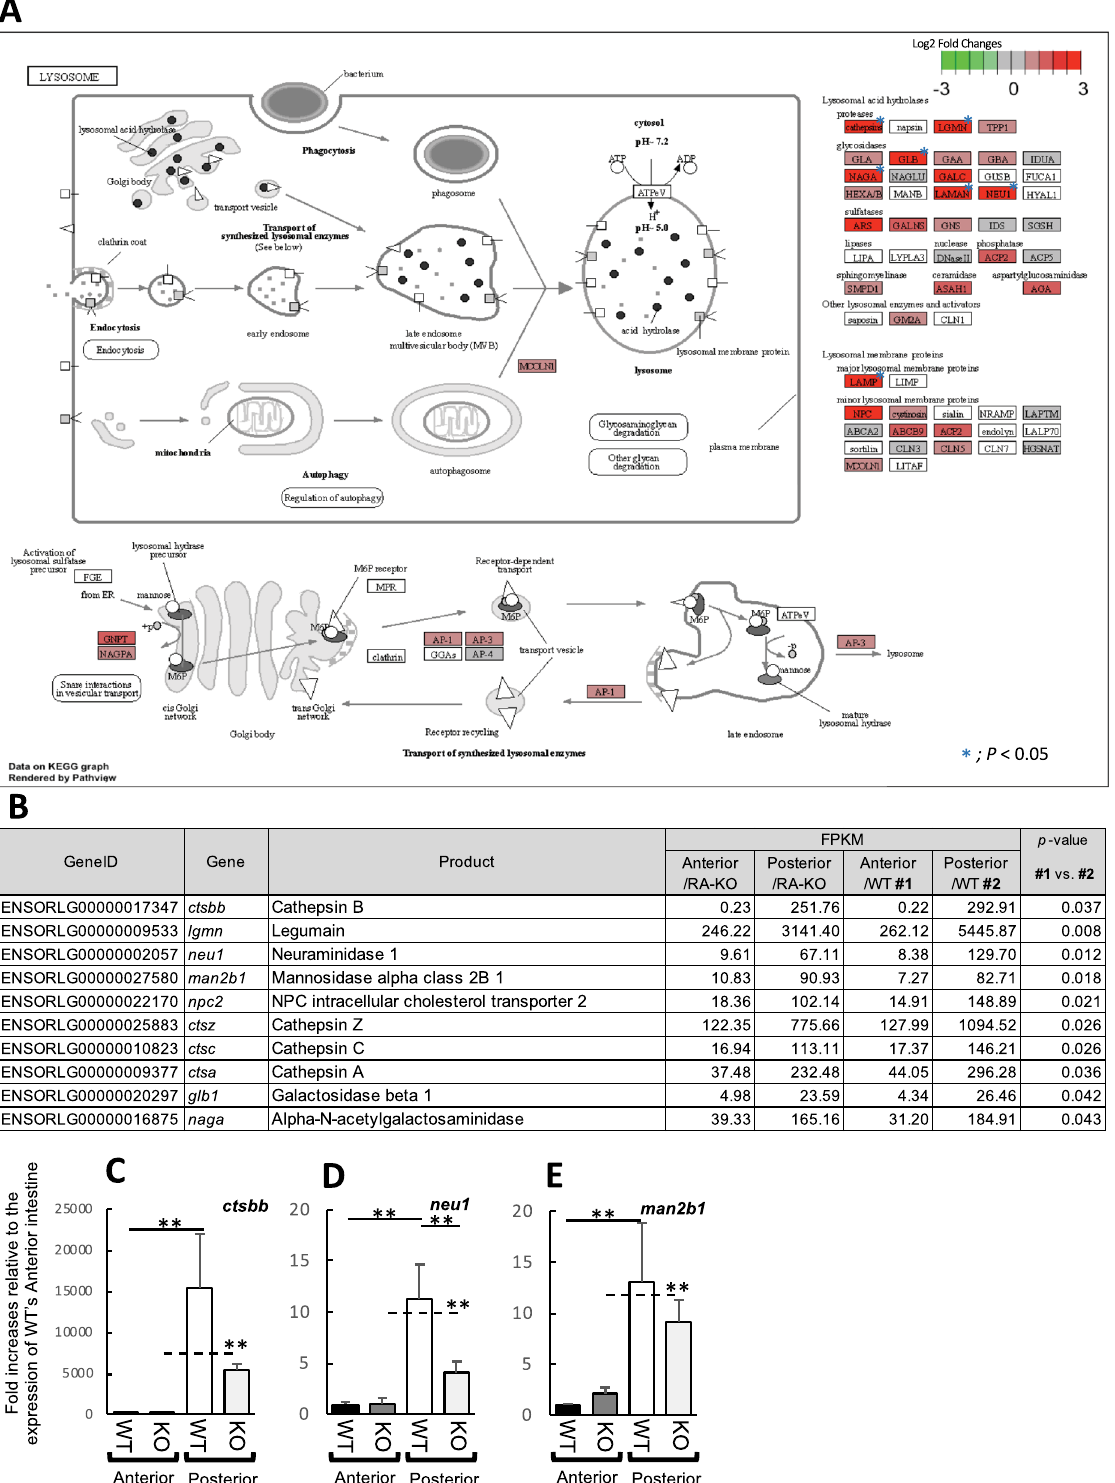
Figure 6. Pathway maps of notable DEGs in the posterior intestines, as determined using the KEGG database. ( A ) Medaka posterior intestines showed enhanced expression of genes related to the “lysosome” (KEGG map04142) pathway, as participated in lysosome formation. ( B ) Ten DEGs were significantly localized in the anterior intestines of WT medaka. ( C–E ) Of these 10 DEGs, the expression levels of cathepsin B ( ctsbb ), neuraminidase 1 ( neu1 ), and mannosidase alpha class 2B member 1 ( man2b1 ) were confirmed by qPCR analysis. ** P < 0.01, * P < 0.05 (Student’s t -test or Welch t -test in R version 3.5.3). The data shown were obtained in one experiment with five individual fish (n =